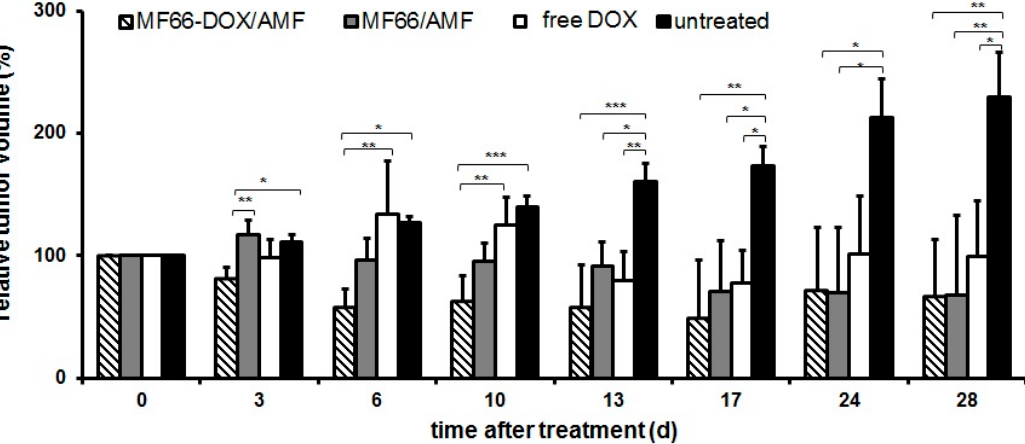
Figure 2. DOX-functionalized MNPs and magnetic hyperthermia significantly reduces tumor volumes in vivo. Tumor volumes (volume percentage to day 0 before treatment), mean ± standard deviation (n ≥ 4 mice per group), (*) p ≤ 0.05, (**) p ≤ 0.01 and (***) p ≤ 0.001.